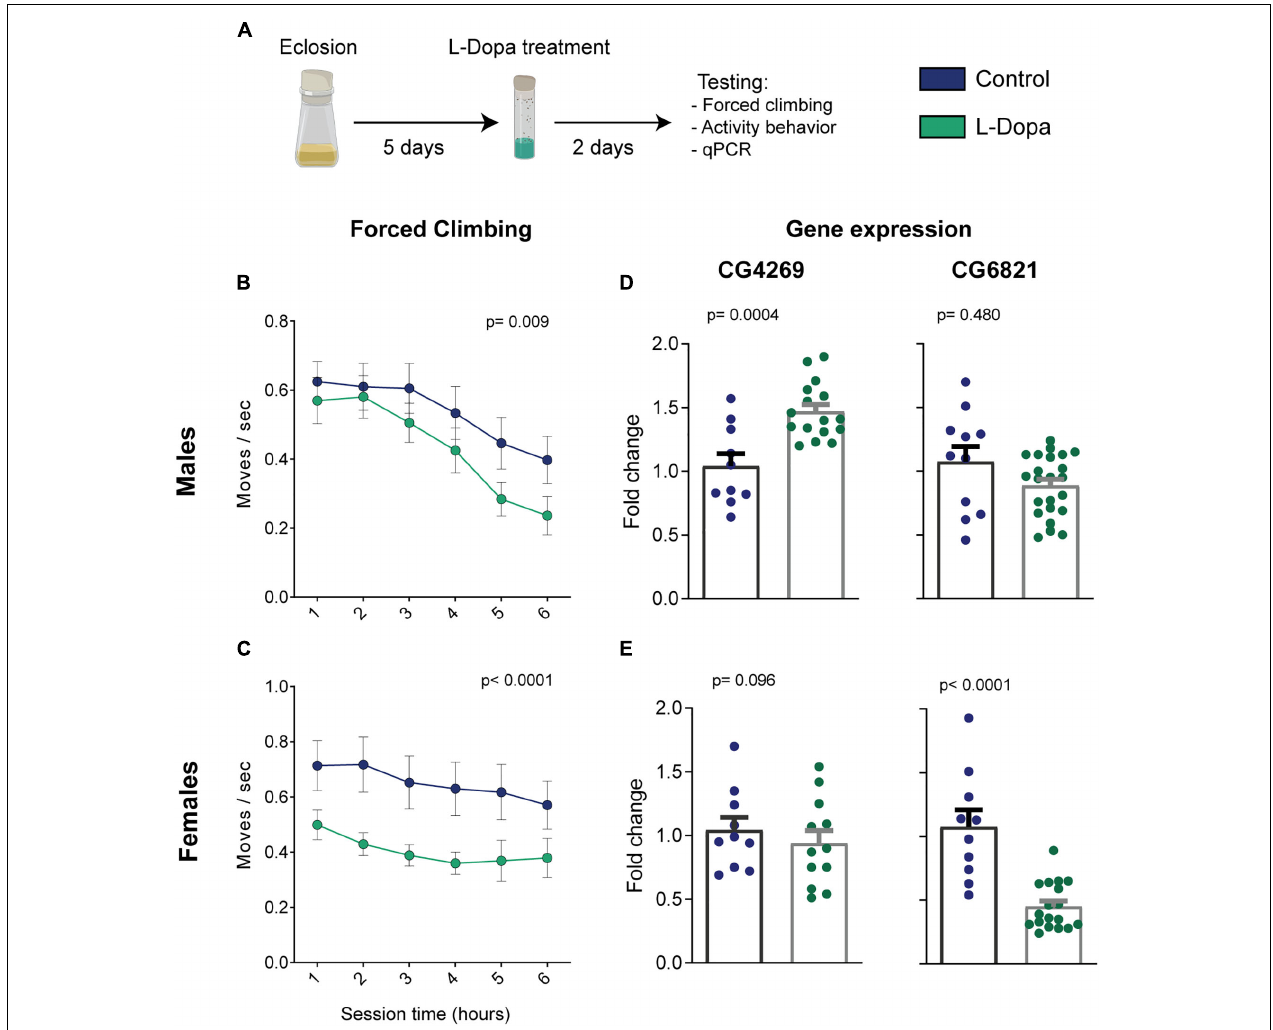
FIGURE 2 | Levodopa-induced phenotypic and genotypic alterations from male and female flies. (A) Illustration of the intervention protocol. (B) Male and (C) female climbing behavior for each hour ( n = 30/23 and 31/24 control/treated flies, respectively; treatment-effect p -values were calculated by two-way ANOVA). (D,E) Relative expression of key genes related to the depression model [ n (CG4269-males) = 10/16; n (CG4269-females) = 10/12; n (CG6821-males) = 11/23; n (CG6821-females) = 10/18 control/treated samples of 25 flies; Student’s t test; all groups passed the D’Agostino and Pearson test for normal distribution]. Bars and errors represent mean ±